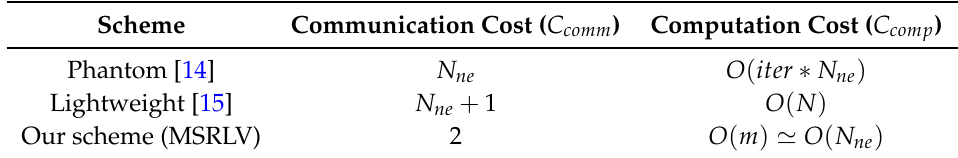
Table 3. Communication and computation cost for the verification of a single